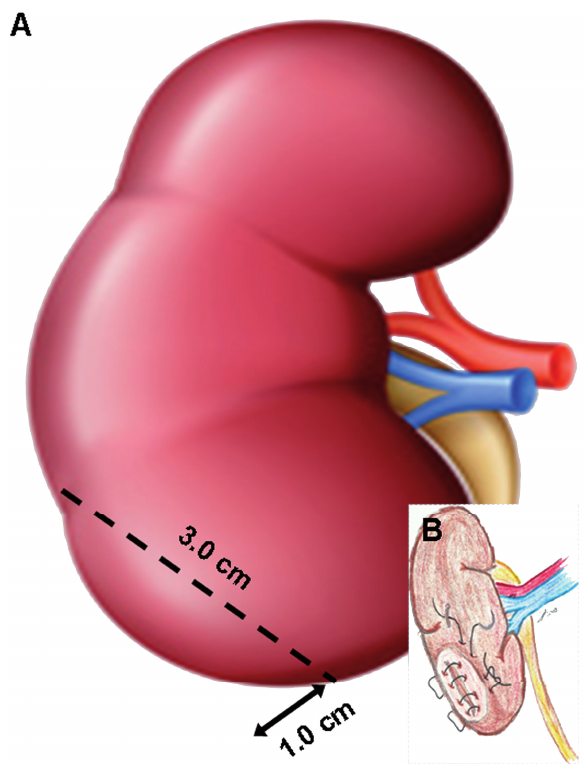
Figure 2 - Partial nephrectomy: A. Lower pole resected. B. “U” suture was